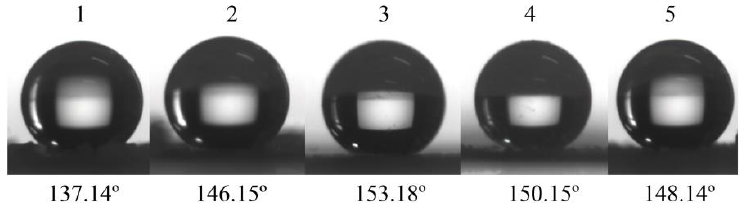
Figure 8. Water contact angle (WCA) images of five different groups.